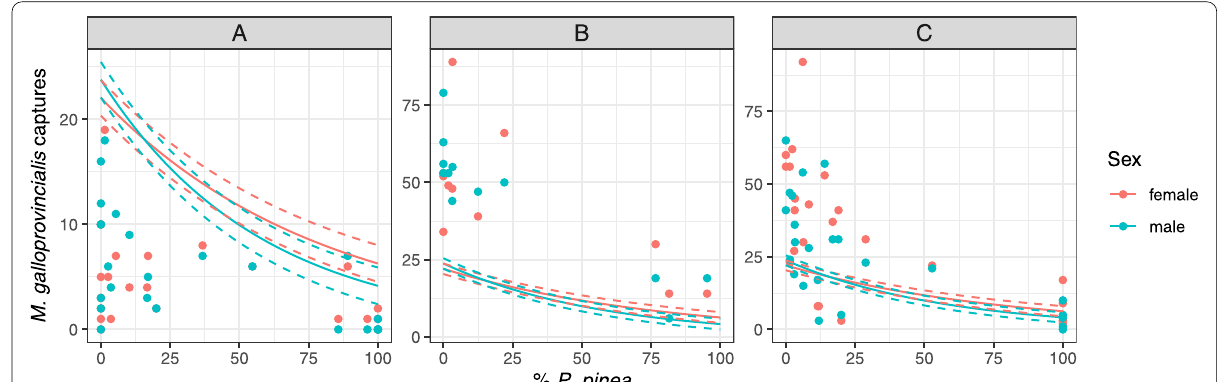
Fig. 3 Effect of % P. pinea at 50 m around traps on captures of males and females of M. galloprovincialis per trap in the three sectors ( A , B , C ). For the sake of visibility, y‑axes differs per sector. Lines correspond to model predictions (solid line) and their standard error (dashed line)